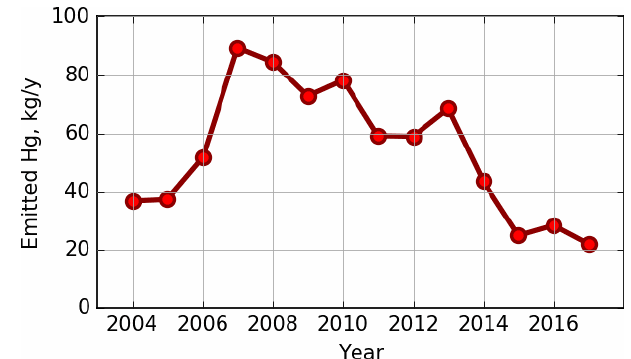
Figure 3. Time series of total Hg emissions from oil sands pro- cessing facilities in the AOSR. Data were compiled from the NPRI database. Numerical values and individual contributions from 2012–2015 are available in Table